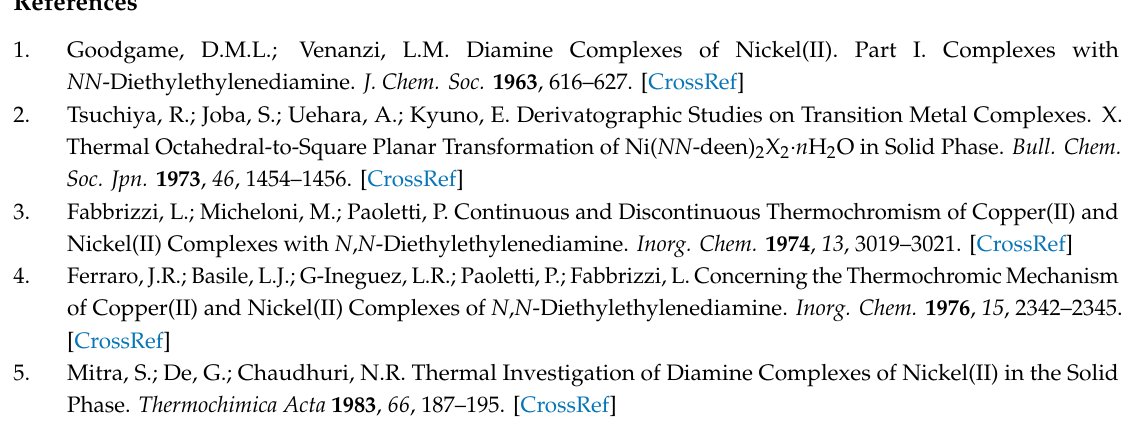
Figure 10. Structural changes of 2a and 2b .